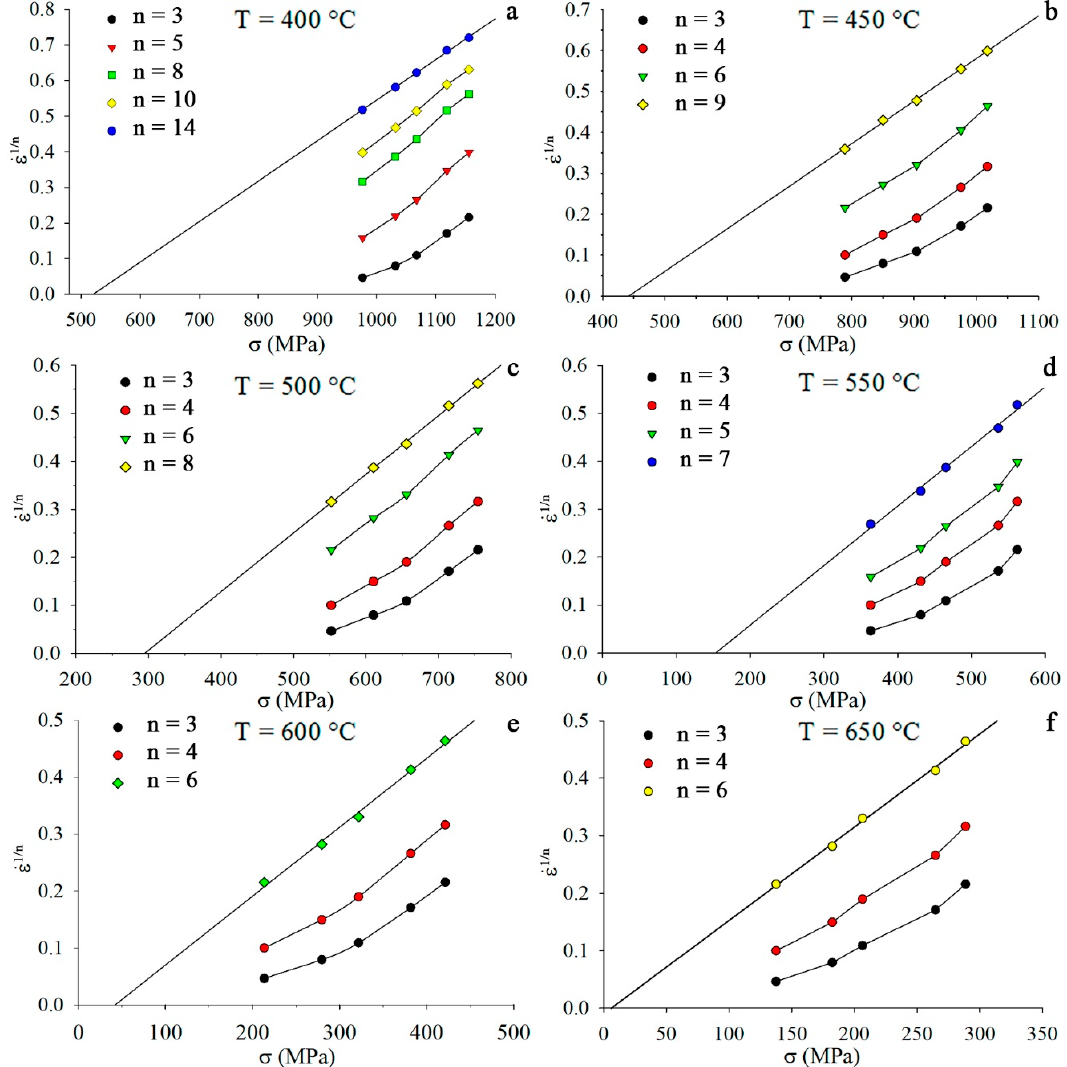
Figure 4. Relationships between (cid:2013) ε 1 / n and σ for temperatures of 400 ( a ), 450 ( b ), 500 ( c ), 550 ( d ), 600 ( e ), and 650 ◦ C ( f ). Table 1. The values of threshold stress ( σ th ), n and corrected activation energy of deformation (Q). Temperature, ◦